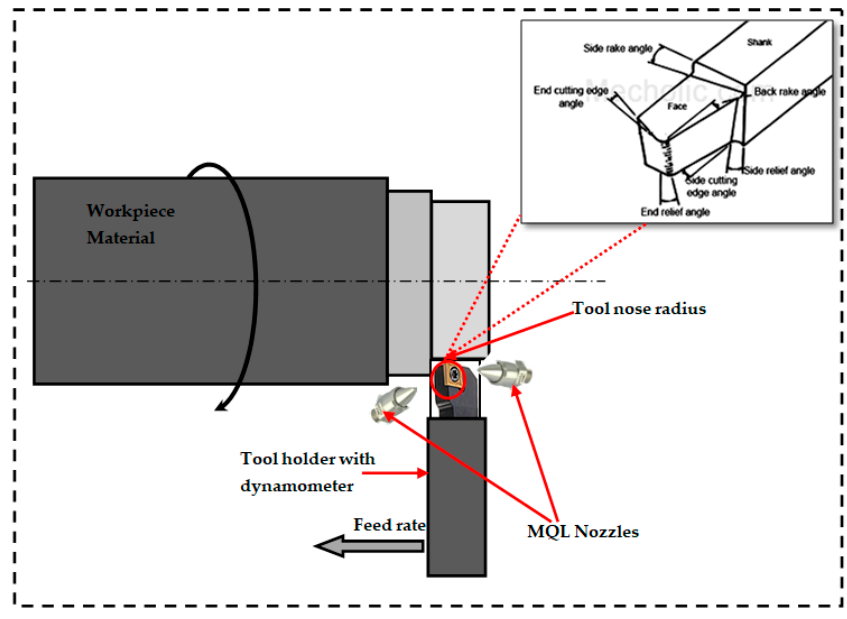
Figure 1. Experimental setup. MQL—minimum quantity lubrication.